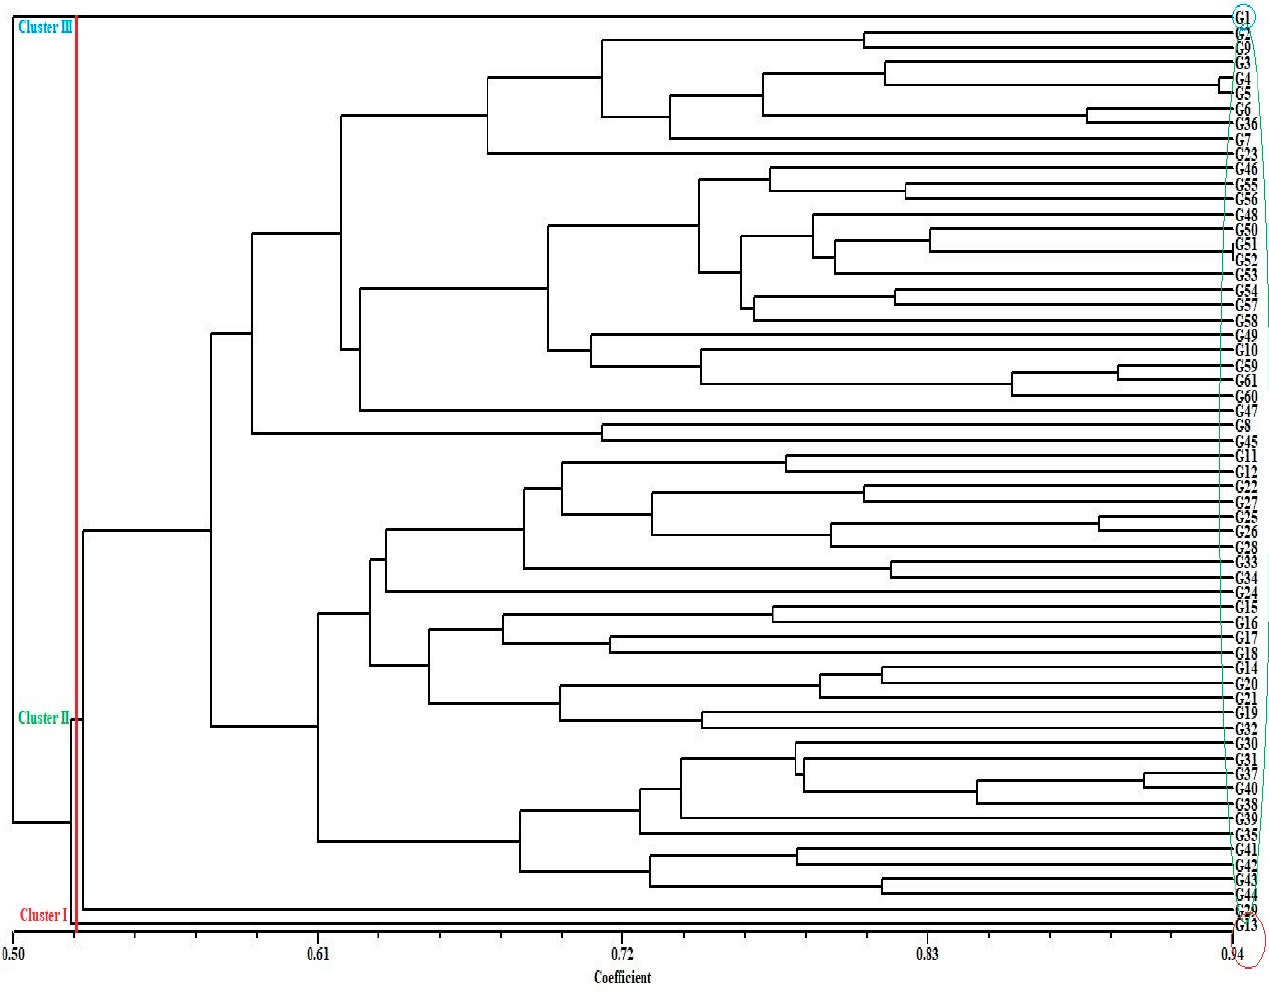
Figure 2. UPGMA dendrogram of 61 forage peas ( P. sativum ssp. arvense L.) landrace accessions based on 28 SSR markers.